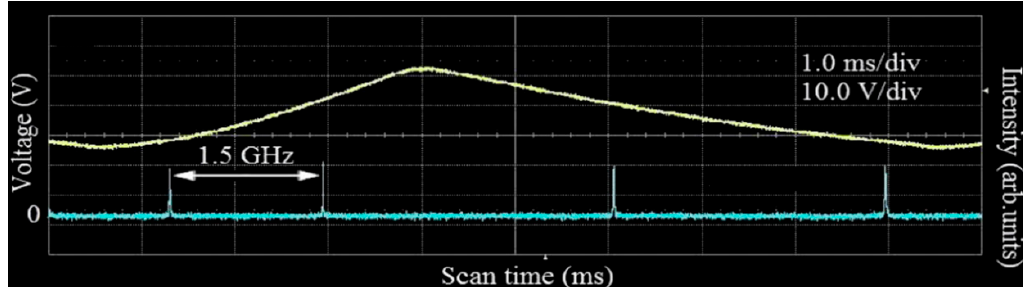
Figure 5. Output mode of the SLM Ho:SSO laser.